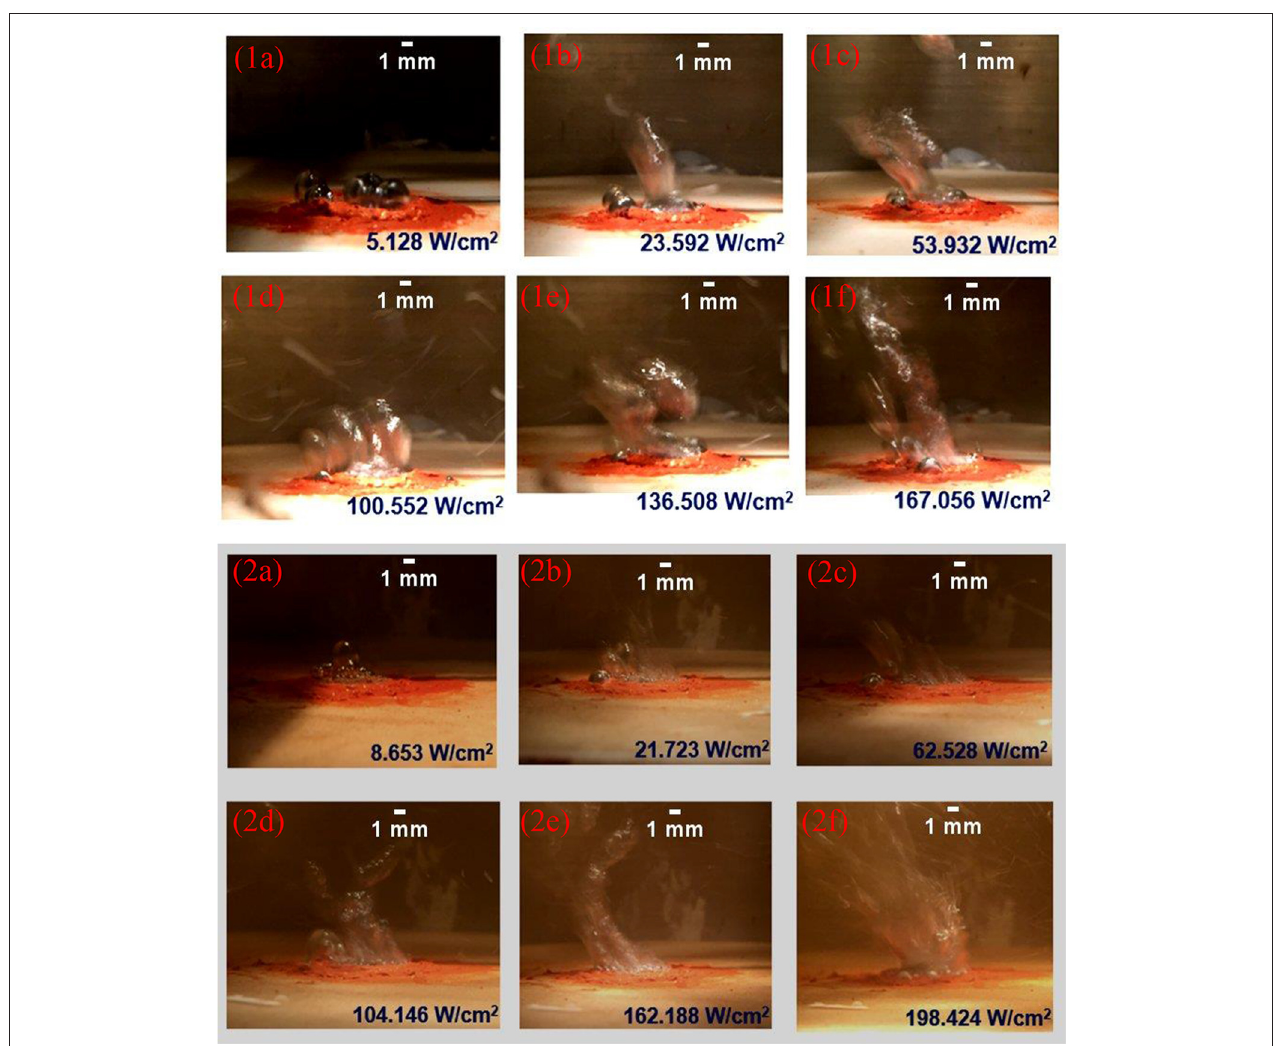
FIGURE 8 | The recorded nucleate pool-boiling images for the 200 µ m mono layer wick structure are shown in 1(a–f) at 0 kPa at different heat fluxes. The high-pressure boiling images at 206.8 kPa for the single-layer wick are shown in 2(a–f) for different heat